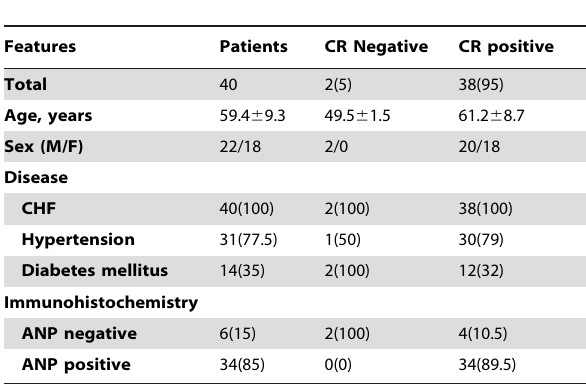
Table 1. Patients Characteristics. Values are means 6 SD or n